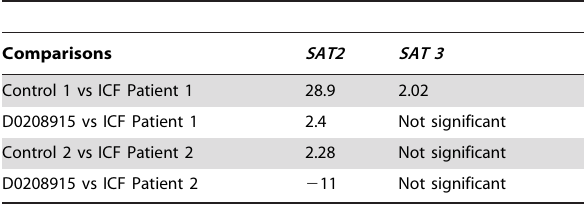
Table 3. Relative quantitation of satellite 2 and 3 using the comparative C t method.